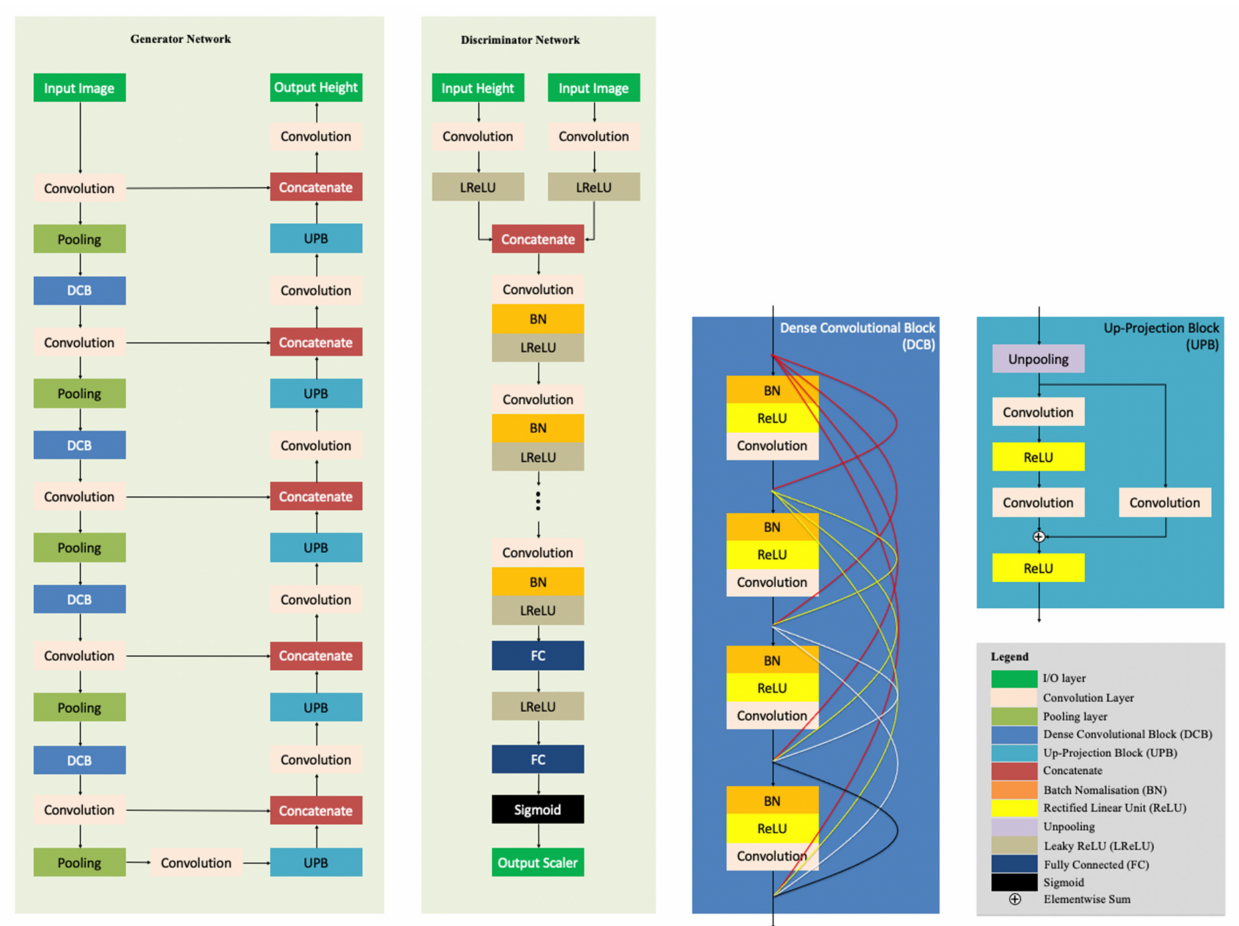
Figure 6. MADNet 2.0 network